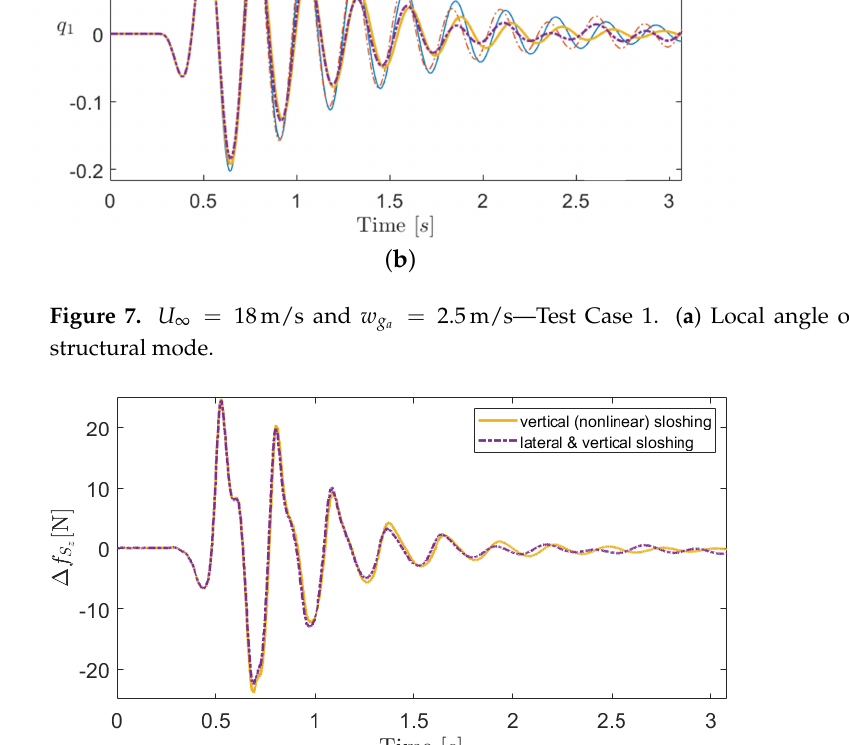
= 2.5m/s—Test Case a